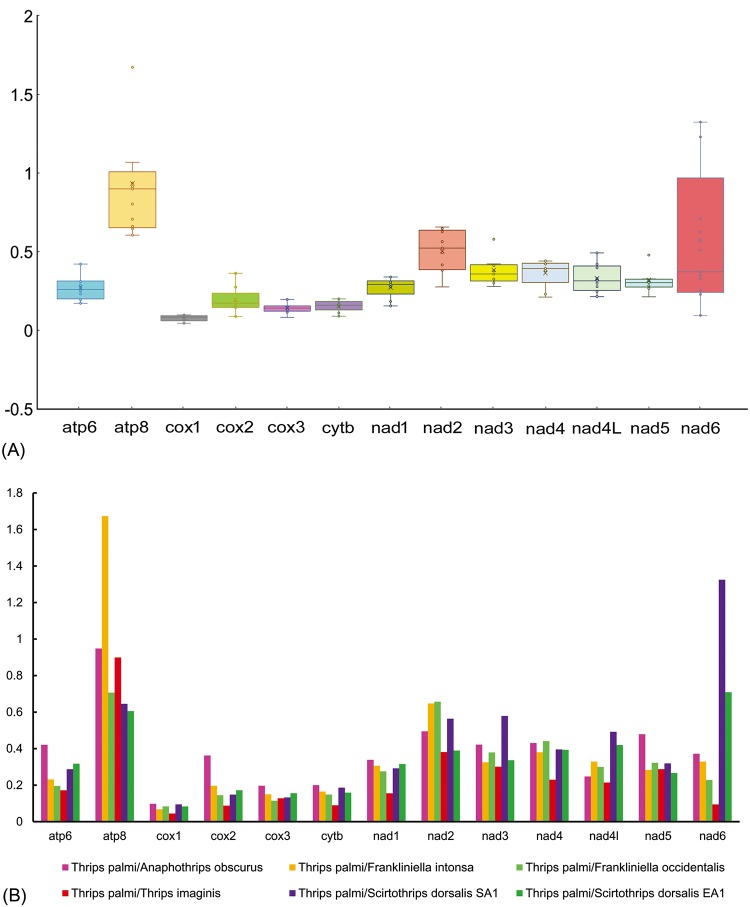
(A) Ratio estimation, box plot for pairwise divergence of Ka/Ks ratio for each one of the mitochondrial PCGs. (B) Evolutionary rates (Ka/Ks) of individuals PCGs of T. palmi with other thrips species.